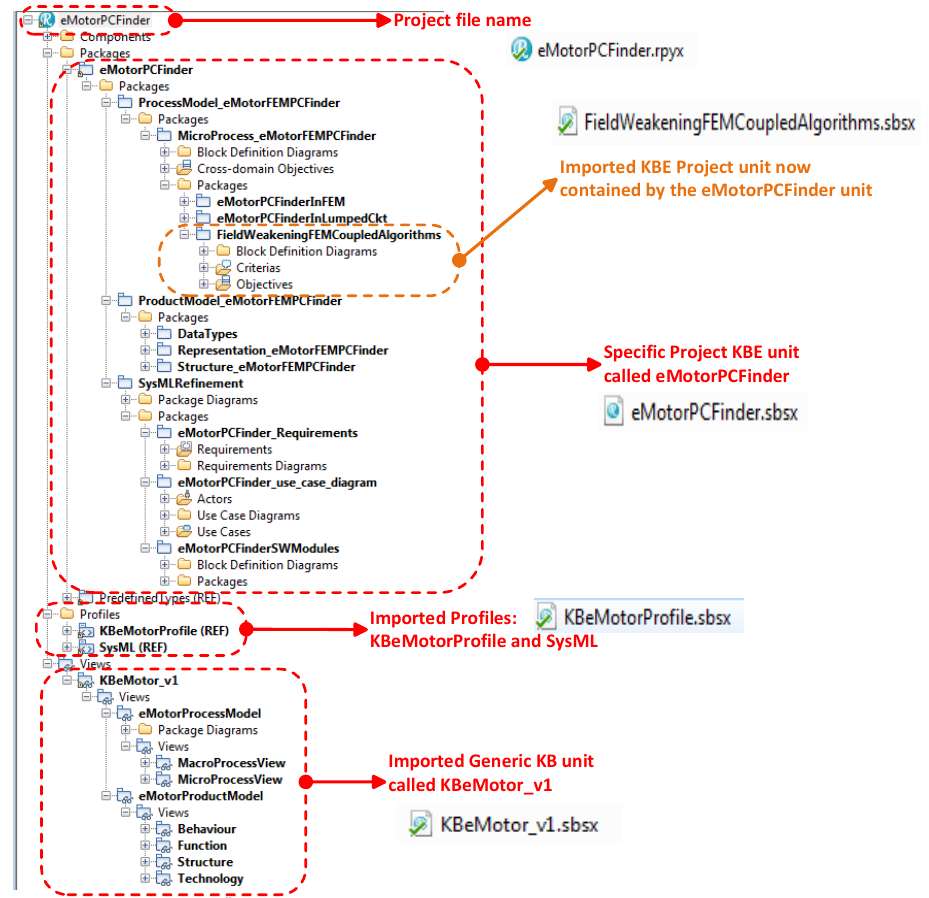
Figure 10. KBE project structure in Rational Rhapsody.